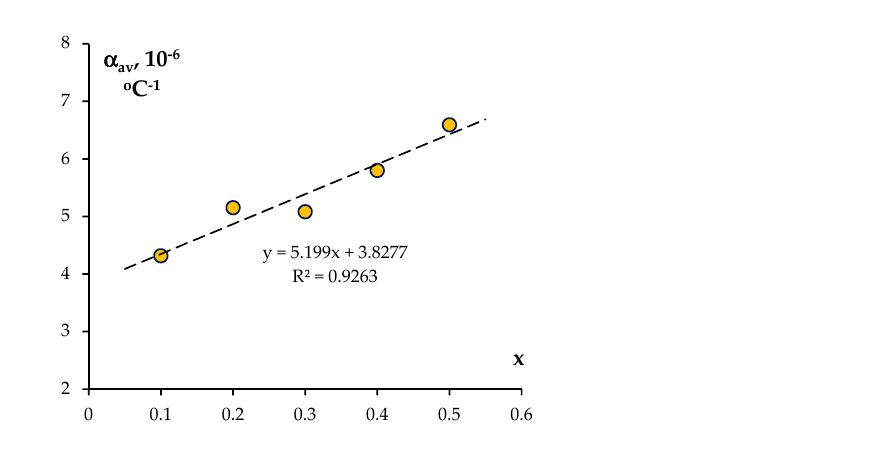
Figure 7. The amount of uniaxial applied pressure and vacuum level was almost constant during heating. There was no intensive decrease in the vacuum pressure, which allows us to conclude that the ceramic crystal structure is thermally stable during heating, and there is no intense dissociation of elements from the specimen surface.